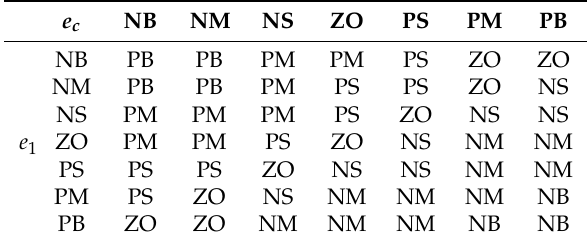
Table 1. The rules base of Fuzzy Logic Control (FLC) for ∆ k 1 .